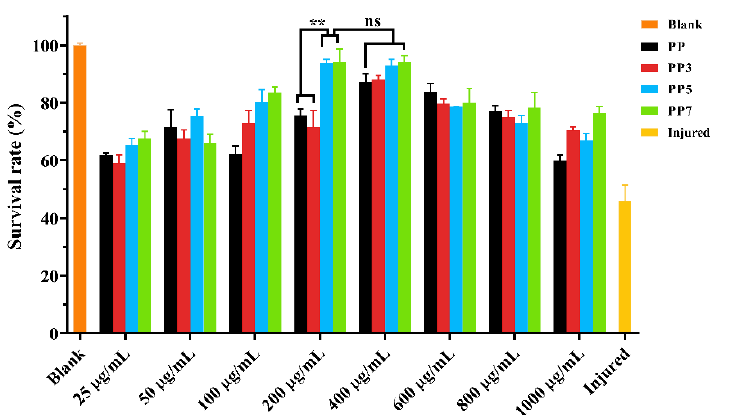
Figure 8. Treatment of PP, PP3, PP5, and PP7 significantly increased the oxidative stress resistance in HHL-5 cells. The values are presented as the mean ± SD ( n = 3). **: Statistically significant differences between compared samples ( p < 0.01), and the “ns” means no significant difference